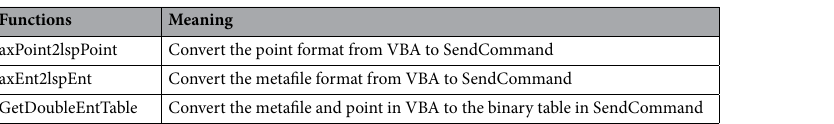
Table 1. Conversion function in